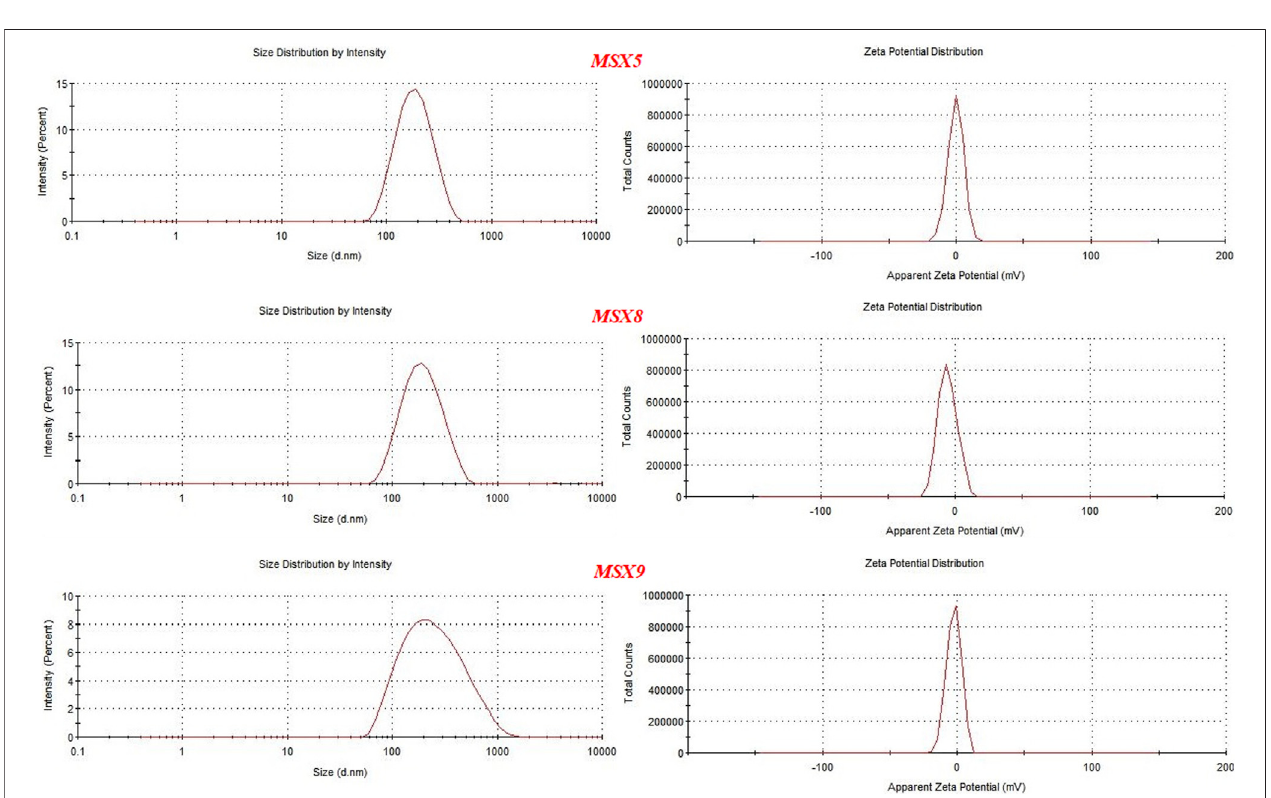
FIGURE 5 | Graphs showing particle size and zeta potential of optimal formulation of methotrexate loaded nanopatricles.